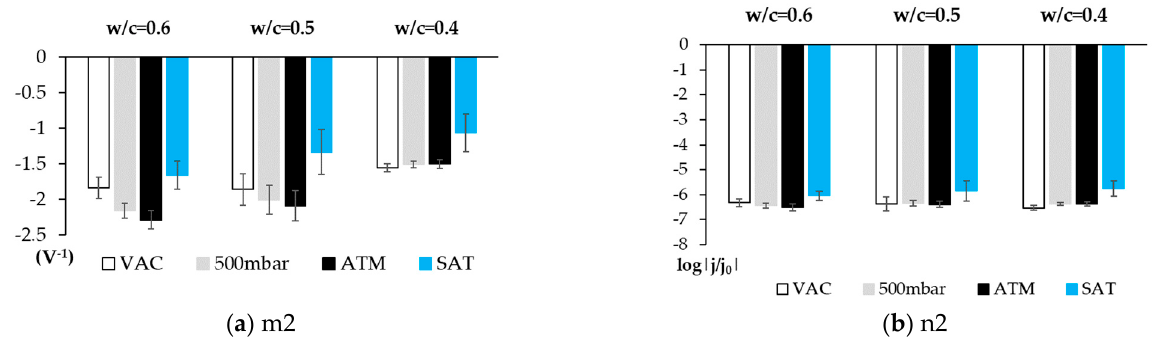
Figure 13. Average value of the slope (m2) and the intercept (n2) of line 2 per studied dosage and for each state. ( a ) Data on the slope of line 2 (m2). ( b ) Data on the intercept of line 2 (n2).